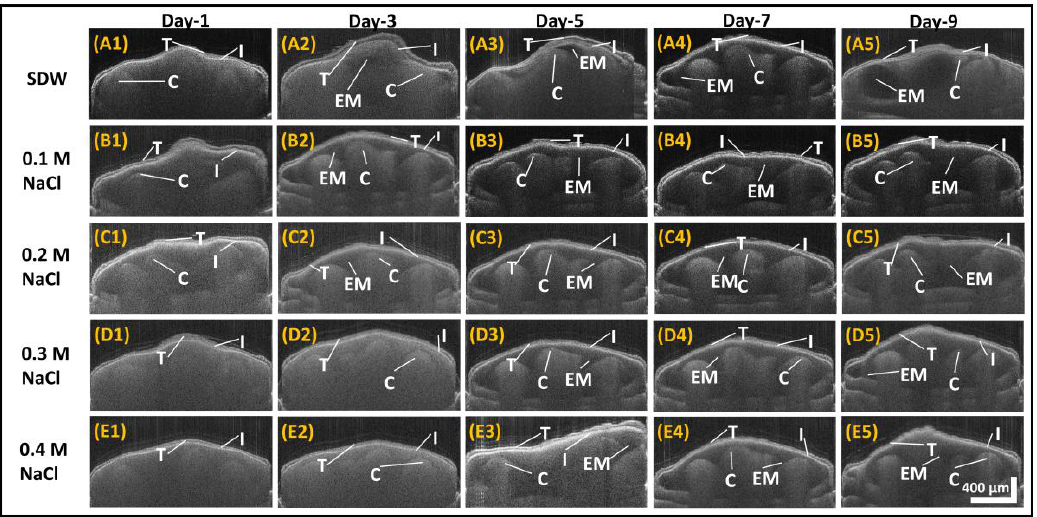
Figure 3. Comparative growth analysis by 2D SS-OCT of Capsicum annuum seeds primed with different salt solutions. The images were taken on consecutive days for seeds that were soaked in sterile distilled water (SDW) ( A1 – A5 ), 0.1 M NaCl solution ( B1 – B5 ), 0.2 M NaCl solution ( C1 – C5 ), 0.3 M NaCl solution ( D1 – D5 ), and 0.4 M NaCl solution ( E1 – E5 ). C: Cotyledon; EM: embryo; I: Inner seed coat; T: Testa. The scale bar of 400 µm applies to all 2D images.